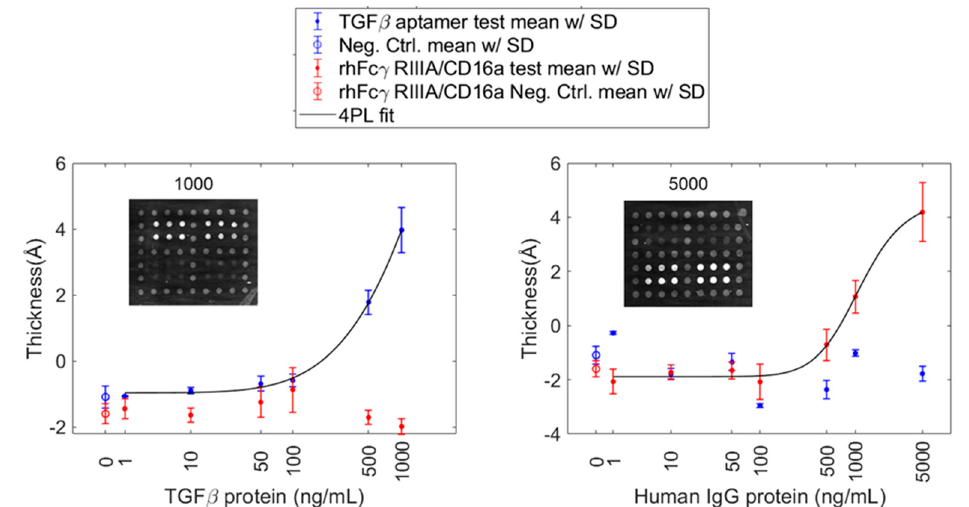
Figure 6. Performance of a dual aptamer-protein AIR array. Concentration-dependent response for arrays exposed to recombinant human TGF β 1 and human IgG. Representative array images are shown in each case for 1000 ng/mL protein exposure. Plots of normalized thickness vs. target protein concentration were fitted with 4 parameter logistic curves. Error bars represent the standard deviation of all probe replicates (n ≥ 8).